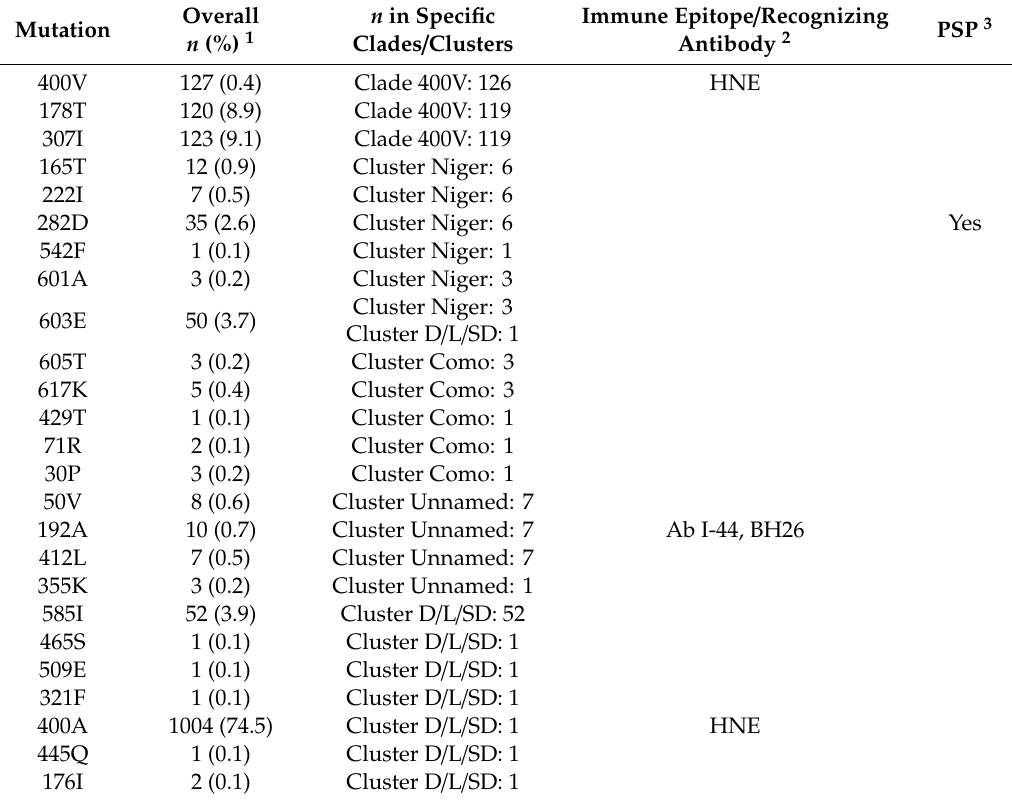
Table 2. Frequency of amino acid mutations involving B3 strains from